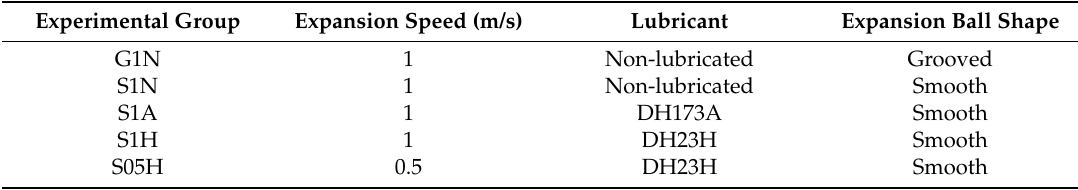
Table 1. Experimental groups for Al tube expansion experiments.